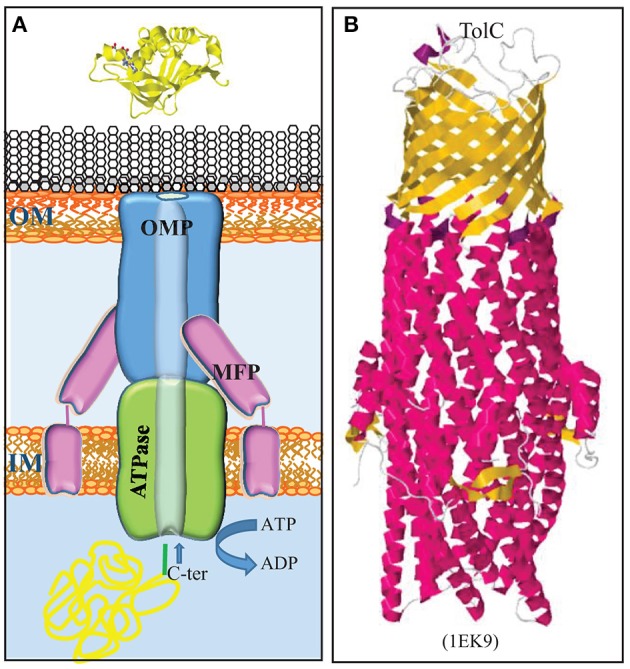
Type 1 secretion system. (A) The T1SS consists of three proteins, a trimeric OMP (blue), an ABC transporter in the inner membrane (IM) (green), and an IM-anchored membrane-fusion protein (MFP) (pink), which together form a translocation channel for substrates directly from the bacterial cytoplasm to the external milieu. Substrates contain a secretion signal at their C terminus (green) for recognition by the machinery. (B) Structure of the homotrimeric OM T1SS component of E. coli, TolC (Koronakis et al., 2000). The trimer consists of a β-barrel in the OM and long α-helices, which form a tunnel that deeply penetrates into the periplasm. β-Strands and α-helices are colored yellow and red, respectively. The PDB access code is given in brackets.